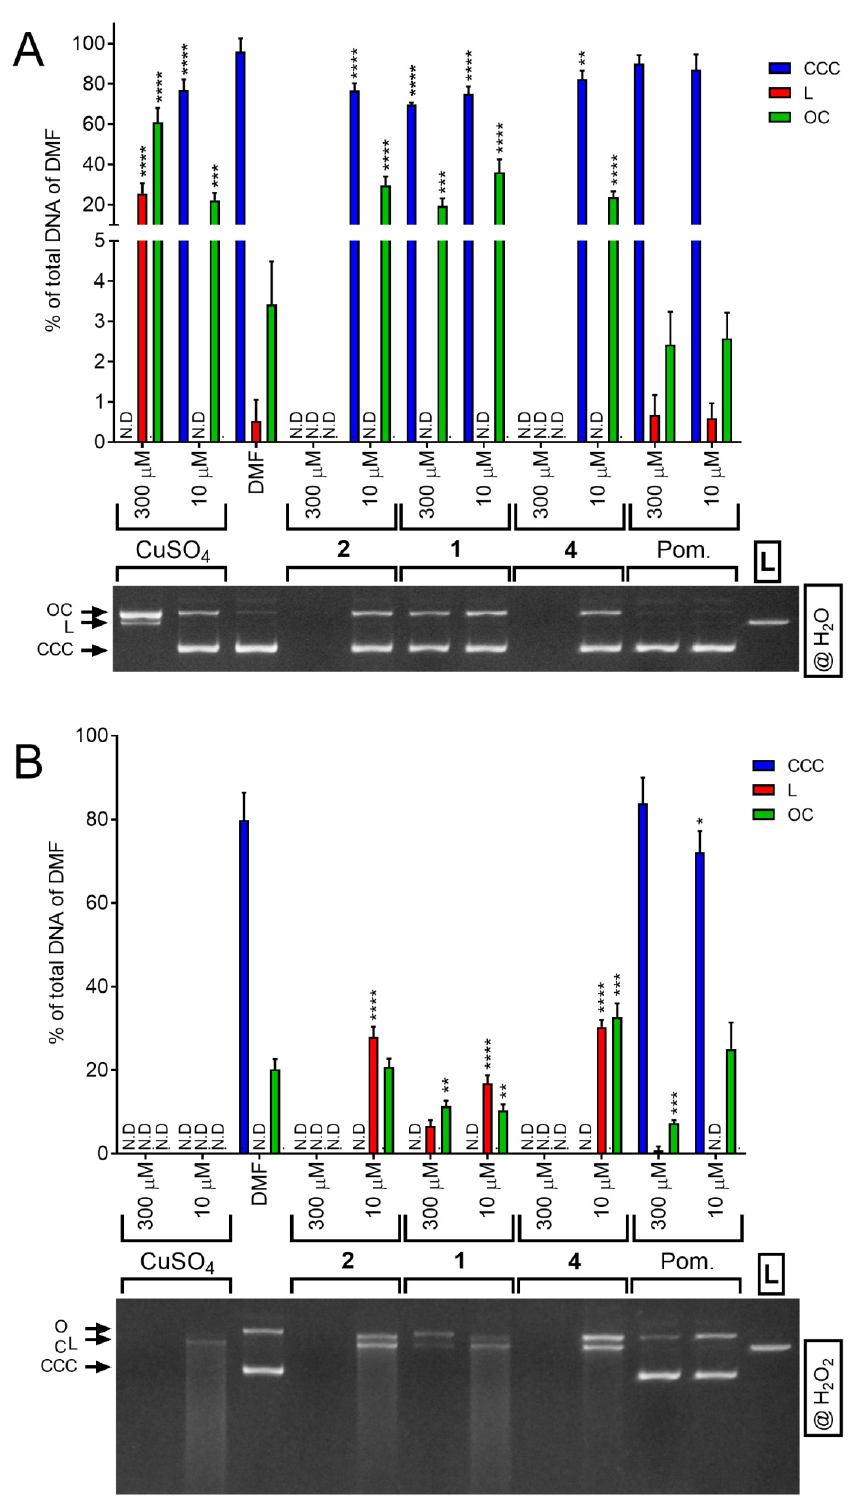
Figure 12. Nuclease-like effect of the tested compounds. Supercoiled plasmid DNA (CCC) was incubated with complexes 1 , 2 , and 4 , CuSO 4 · 5H 2 O, pomiferin (Pom.) or pure solvent (10% DMF in water) in different concentrations at 37 ◦ C for 1 h in water ( A ) or in 0.66 mM H 2 O 2 ( B ). After incubation, the amount of created open circle (OC) and linear (L) form of plasmid was evaluated by densitometry analysis. Graphs show means ± SEM of four independent experiments, electrophoretograms represent the results of agarose electrophoresis. * indicates statistical difference to 10% DMF group ( p ≤